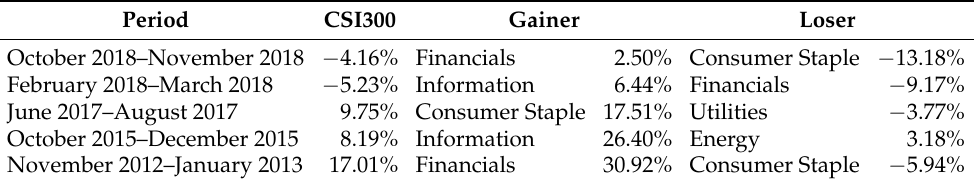
Table 1. The periods with sector risk for CSI300 index from 2014 to